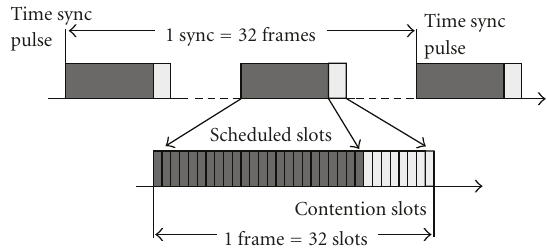
Figure 3: RT-Link time slot allocation with out-of-band synchro- nization pulses.